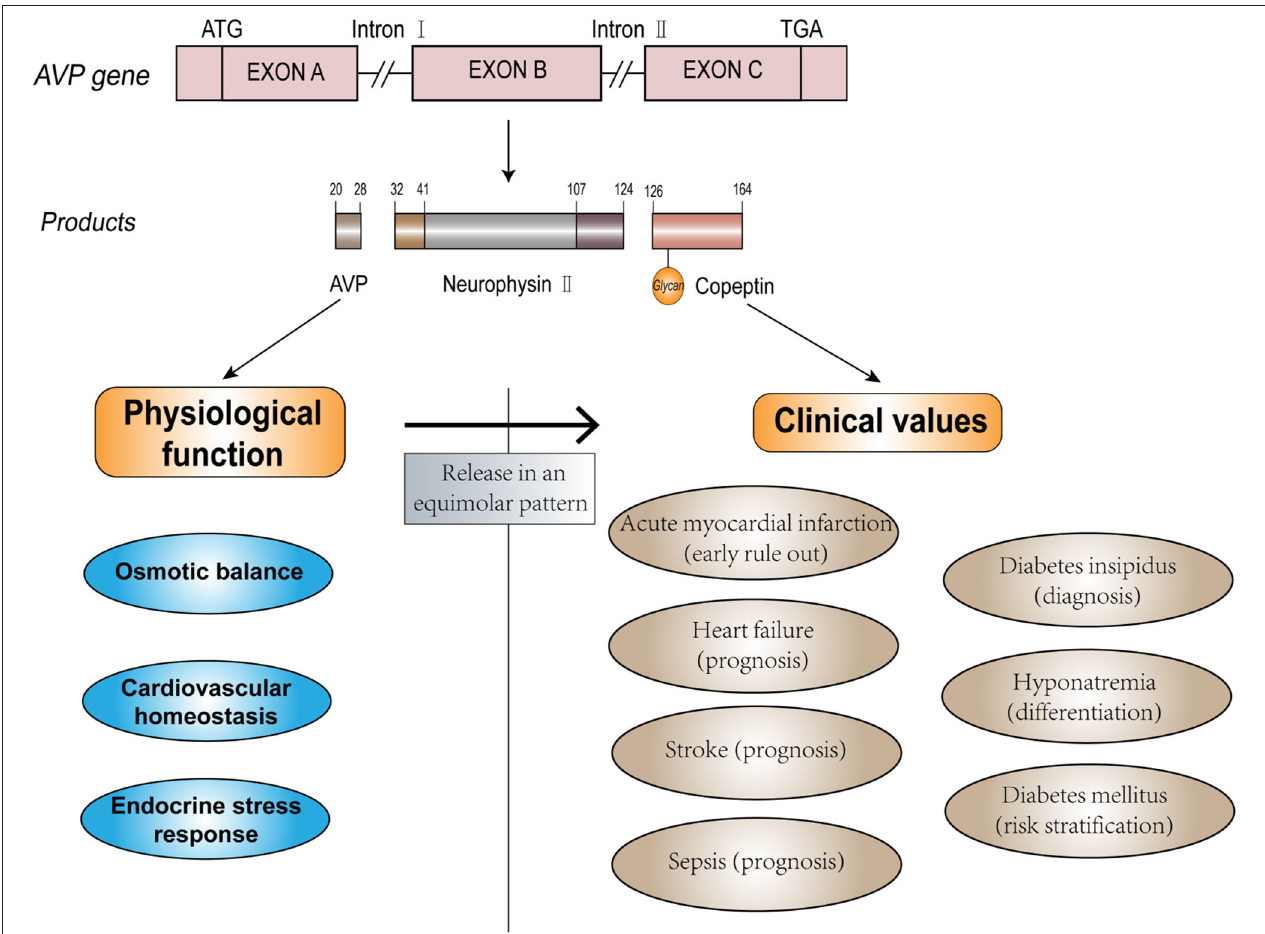
FIGURE 1 | The structure, function, and clinical values of AVP and